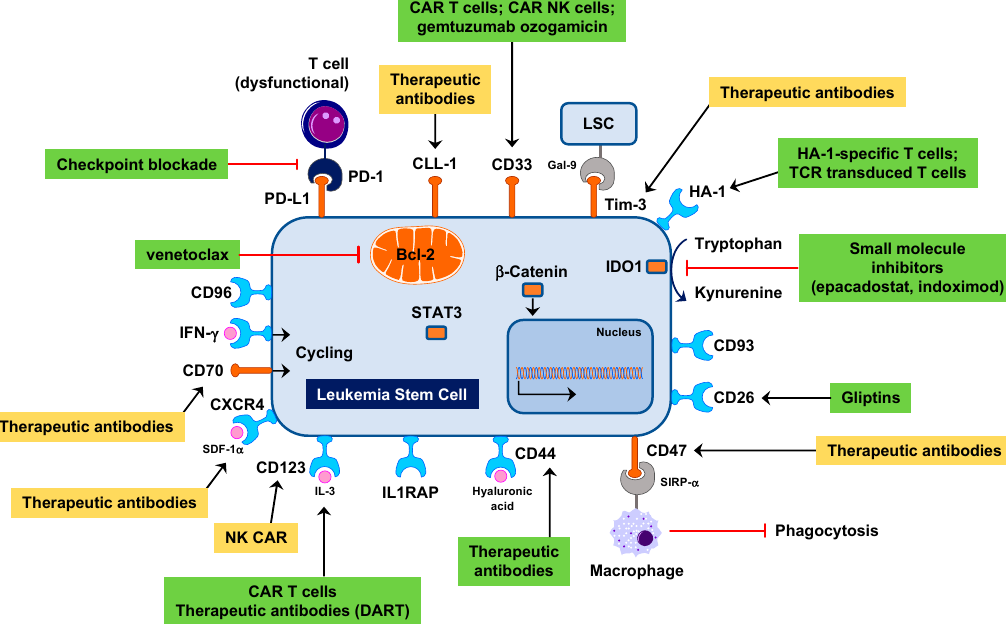
Figure 2. Actionable targets expressed in leukemia stem cells. Therapeutic strategies currently being evaluated include the use of chimeric antigen receptor (CAR)-modified T cells and antibodies such as bi-specific CD3 × CD123 dual affinity re-targeting (DART) molecules [117]. Green boxes highlight therapeutic strategies that are being investigated in clinical trials, such as CD33 [118] and CD44 targeting [119] and Bcl-2 antagonism [120], whereas yellow boxes denote therapeutic approaches, such as CXCR4 [21] and CD47 targeting [121] and TIM-3 blockade [8], that have been explored in murine models of leukemia. LSC = leukemia stem cell.